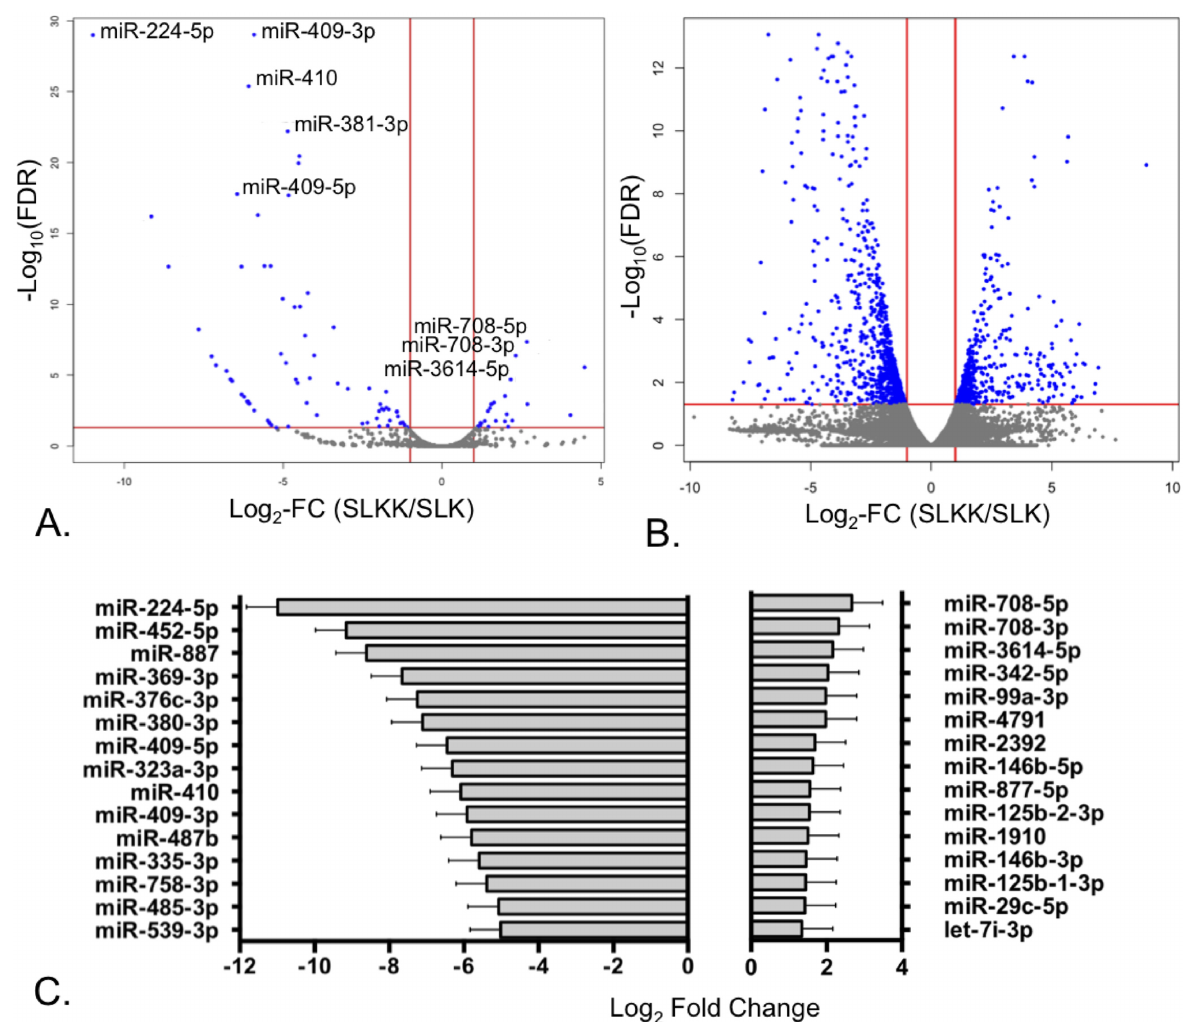
Fig 2. Expression of miRNAs and mRNAs in the analyzed libraries. A. Volcano plot of differentially expressed human mature miRNAs in KSHV-infected versus uninfected cells. Vertical red lines indicate the threshold for a relative expression fold change (FC) of 2 or -2 fold compared to uninfected controls. The horizontal red line represents the threshold of a 0.05 P-value. Thus, the blue points lying in the top right and top left sectors are significantly up-regulated and down-regulated, respectively, in KSHV-positive versus KSHV-negative cells ( P < 0.05, FC (cid:1) 2 or (cid:3) -2). Selected miRNAs that have been validated by qRT-PCR are labeled. B. Volcano plot of differentially expressed mRNAs in KSHV-infected versus uninfected cells. The plot is depicted as in Fig 2A, with vertical and horizontal red lines similarly representing the thresholds of a fold-change of 2 or -2 fold, and of a false-discovery rate (FDR) of 0.05 respectively. C. Top 15 repressed and induced miRNAs in KSHV-positive vs. uninfected SLK cells with P < 0.05 and medium to high miRNA expression (threshold of a mean miR count of 10 or more across all replicates).